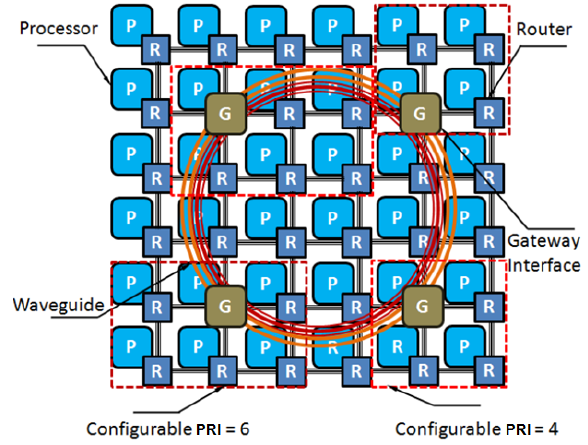
Figure 1. Hybrid photonic ring-electrical mesh Network on Chip (NoC) architecture [10]. Table 1. Summary of Synthesis